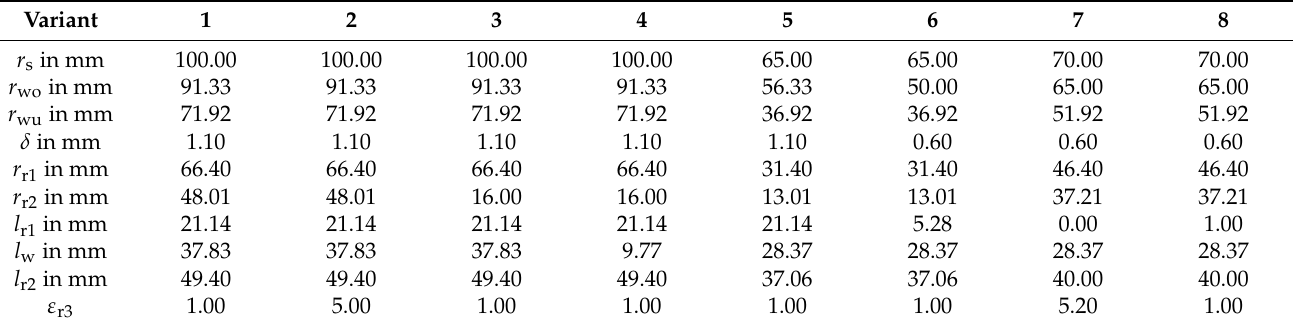
Table 4. Geometric and material properties of the investigated end-winding